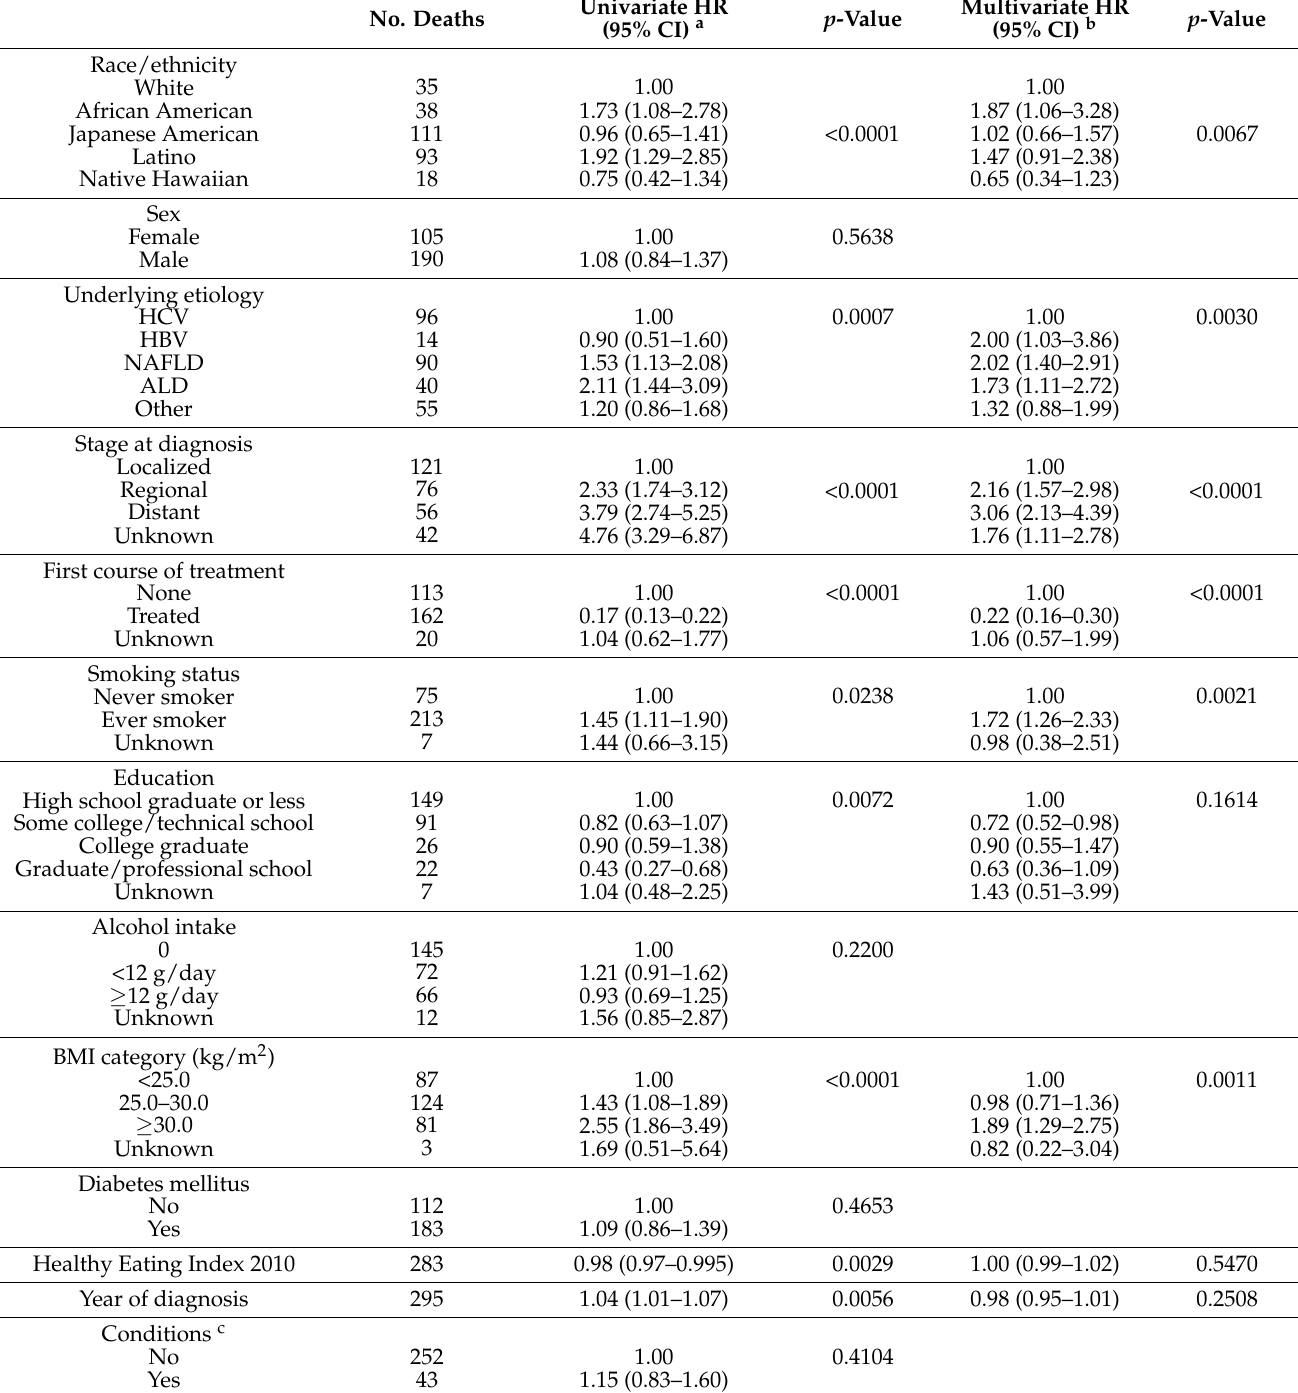
Table 3. Association of race/ethnicity and other factors with overall